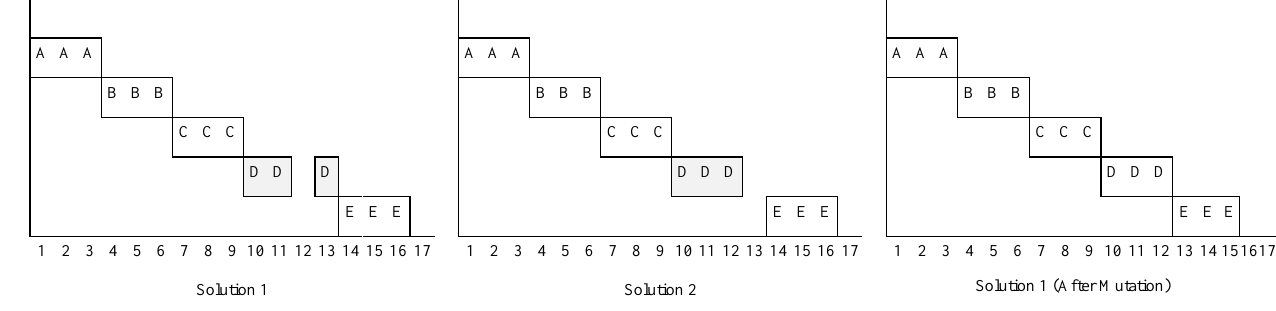
Fig. 6. A typical Bit string Mutation